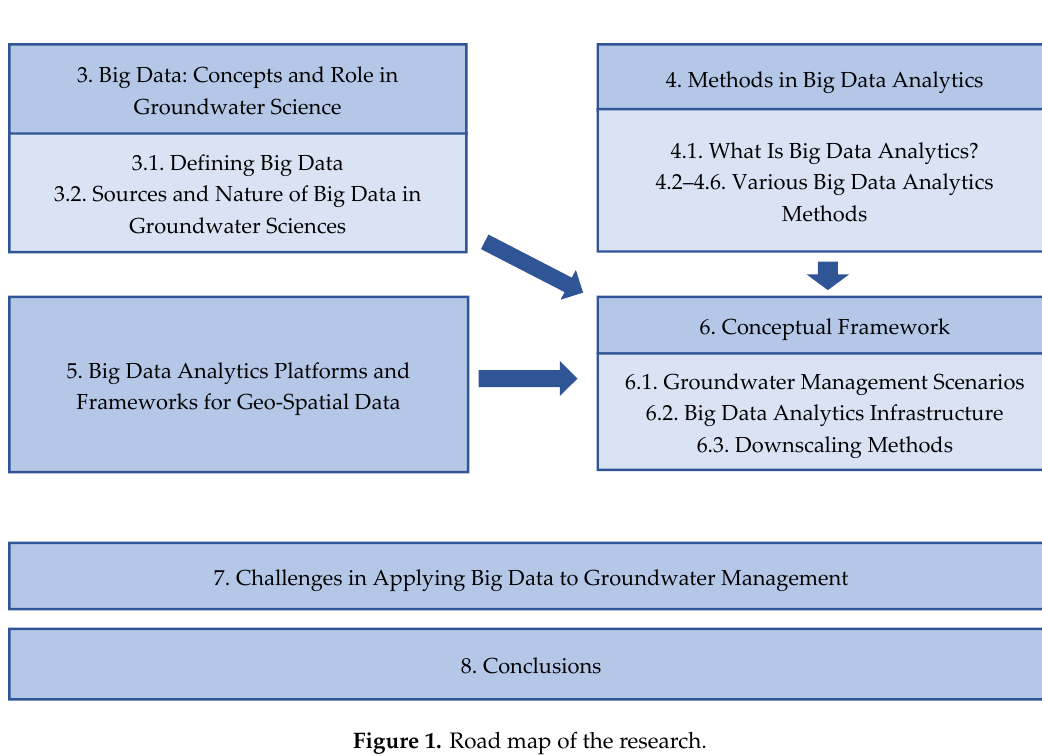
Figure 1. Road map of the research.